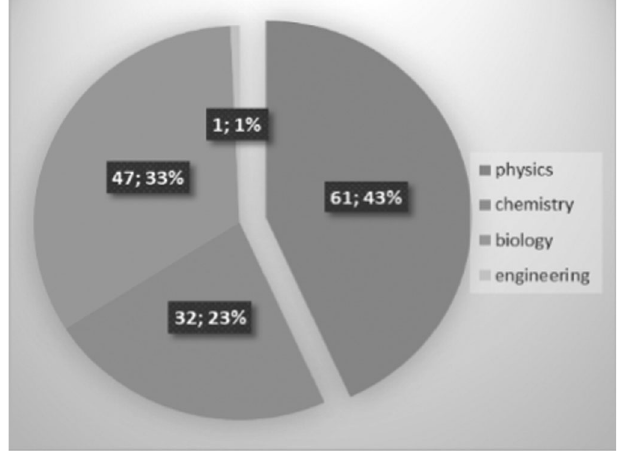
FIG. 2. Distribution of the analogies used in science textbooks among the